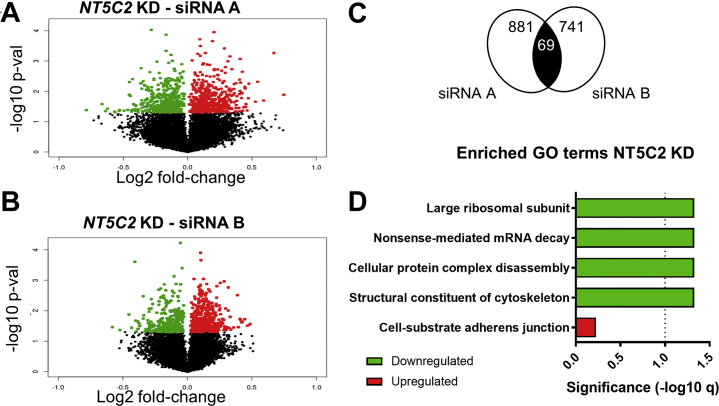
Transcriptional changes associated with the knockdown (KD) corroborate a role for NT5C2 on protein translation. Volcano plots indicate nominally significant transcriptomic changes elicited by (A) small interfering RNA (siRNA) A and (B) siRNA B. (C) Venn diagrams indicating the number of genes differentially regulated by siRNA A and siRNA B and the overlapping gene set, which is unlikely to occur by chance, according to Fisher’s exact test (p < .001). (D) Gene ontology (GO) terms enriched within genes concordantly, differentially expressed in both KD conditions. The line indicates the significance threshold (−log10 q < .05). mRNA, messenger RNA; p-val, p value.